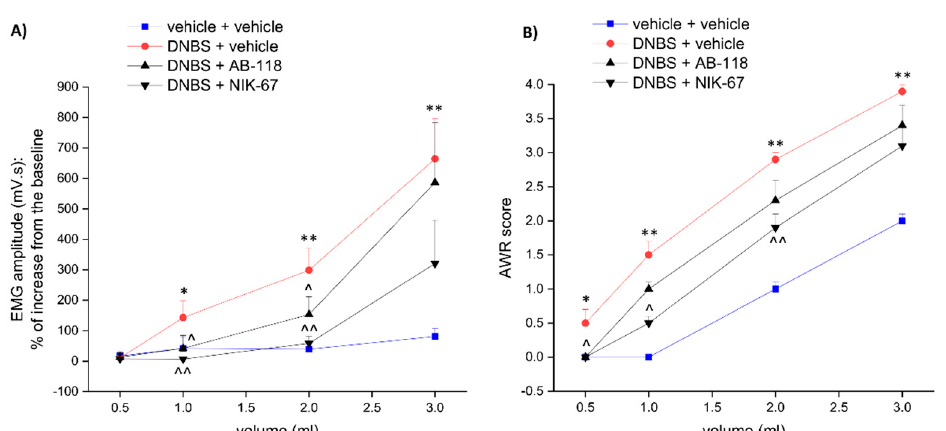
Figure 1. Structures of AB ‐ 118 and NIK ‐ 67.